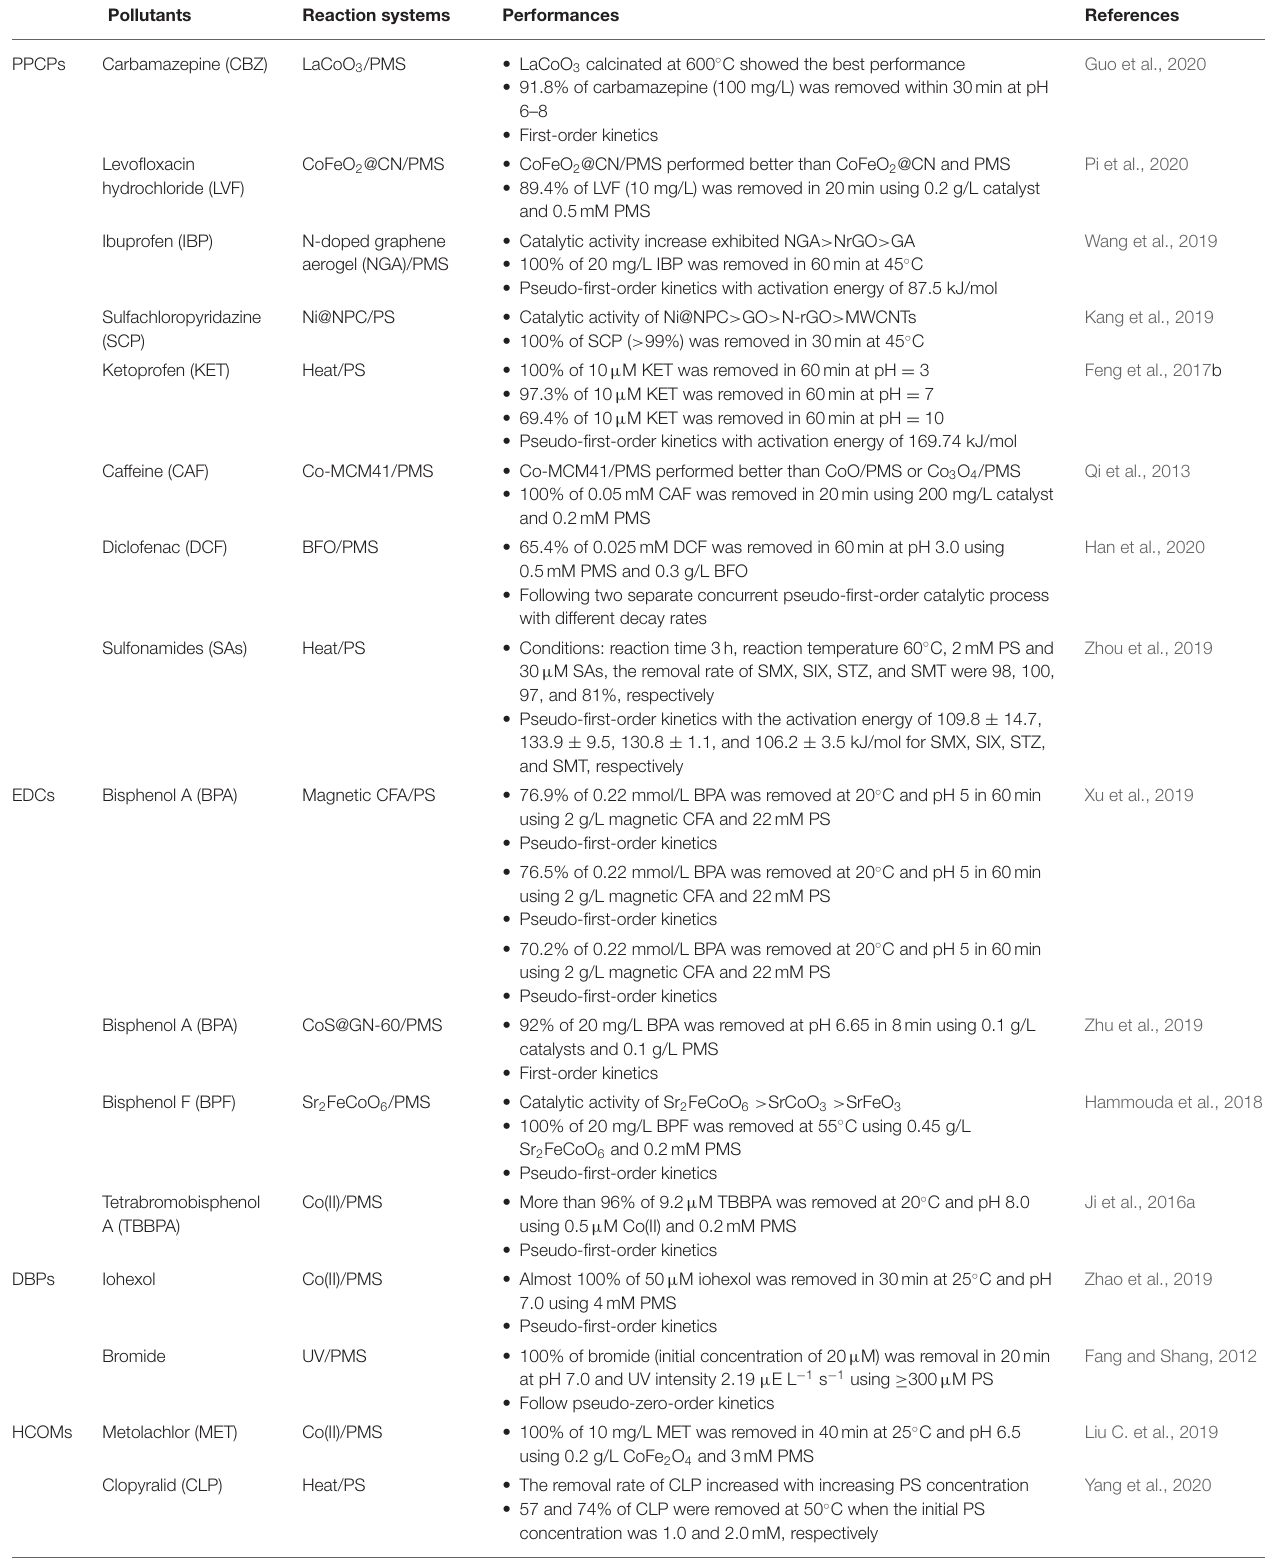
TABLE 2 | Performance of typical pollutants under different reaction